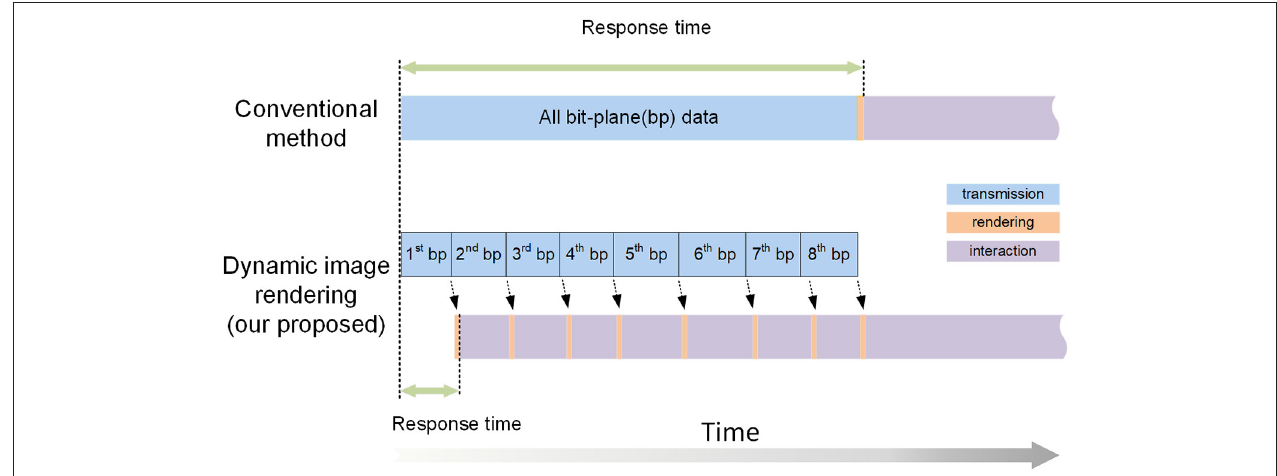
FIGURE 3 | An illustration of dynamic image rendering. The squares of different colors represent the processes of data transmission, rendering, and interactive visualization. Our proposed method transmits the data for each bit-plane individually to achieve a short response time. In contrast, the conventional methods must transfer all the data before interactive visualization can